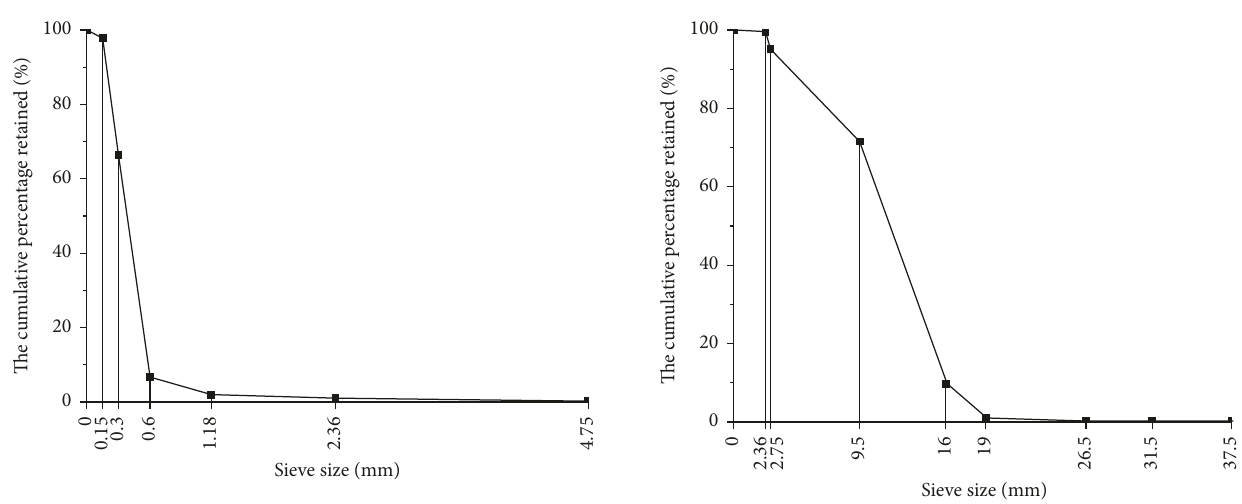
Figure 1: Fine aggregate sieving